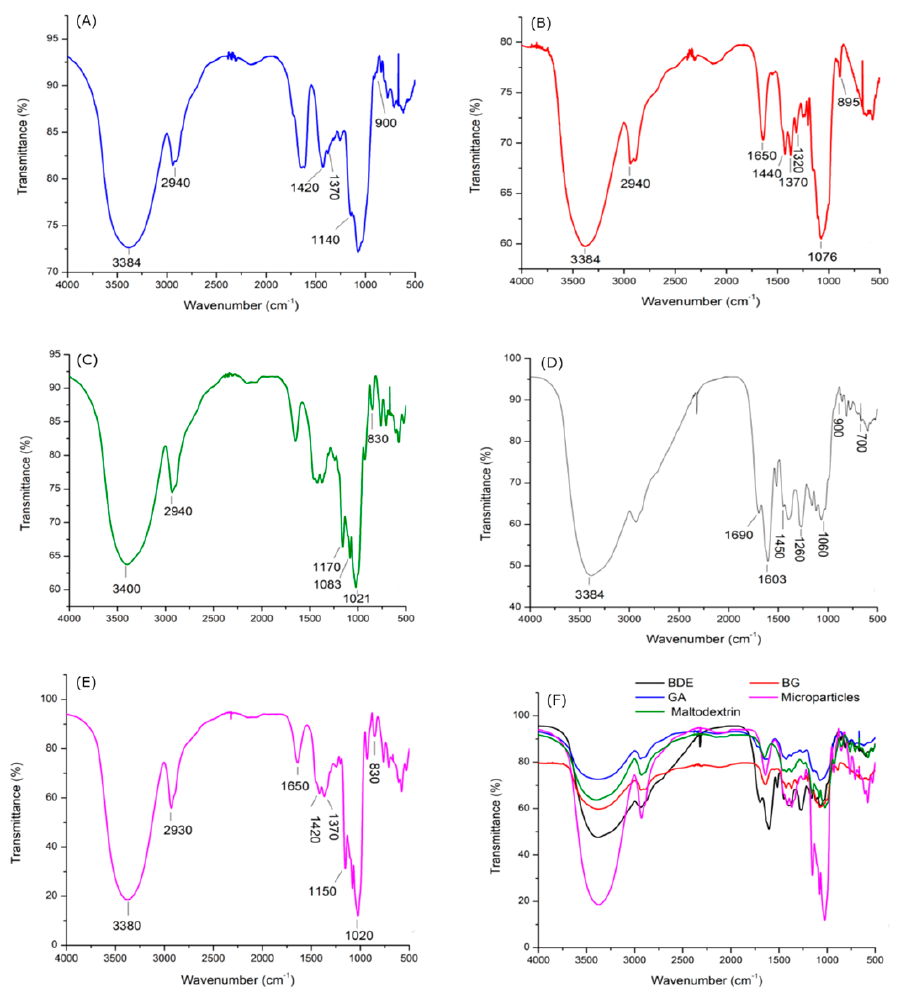
Figure 7. FT-IR spectra of gum arabic ( A ), β -glucan ( B ), maltodextrin ( C ), B. dracunculifolia extract ( D ); microparticles obtained in run 6 ( E ), and overlapped spectra ( F ).